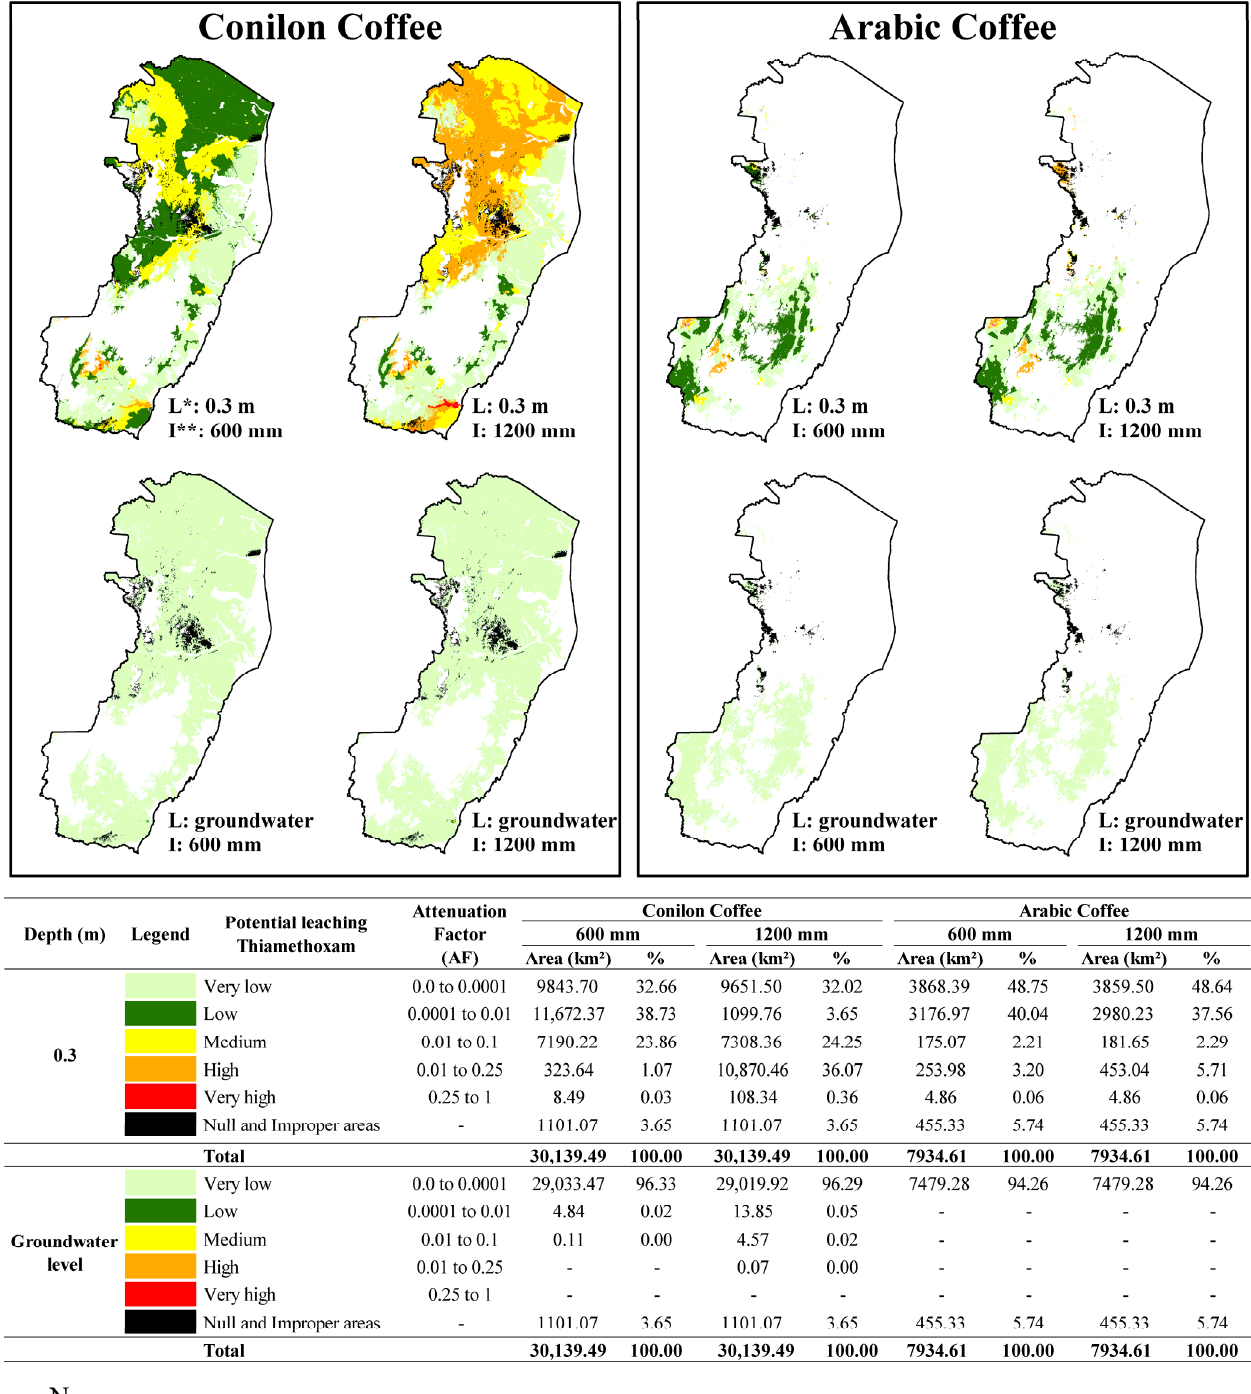
Figure 2. Attenuation Factor ( AF ) of active ingredient thiamethoxam evaluated for edaphoclimatically suitable areas for conilon ( Coffea canephora Pierre ex Froehner) and arabica ( Coffea arabica L.) coffee in Espírito Santo state, Brazil. * L: Groundwater depth and ** I: Irrigation.